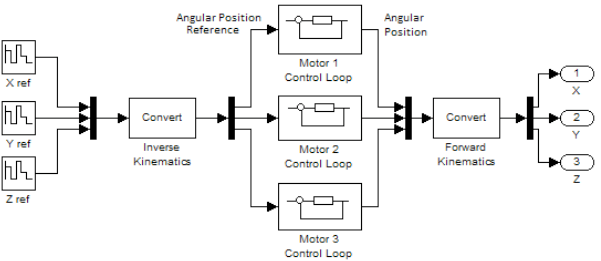
Figure 5: Position control strategy for the Novint Falcon Figure 8. Position control strategy for the Novint